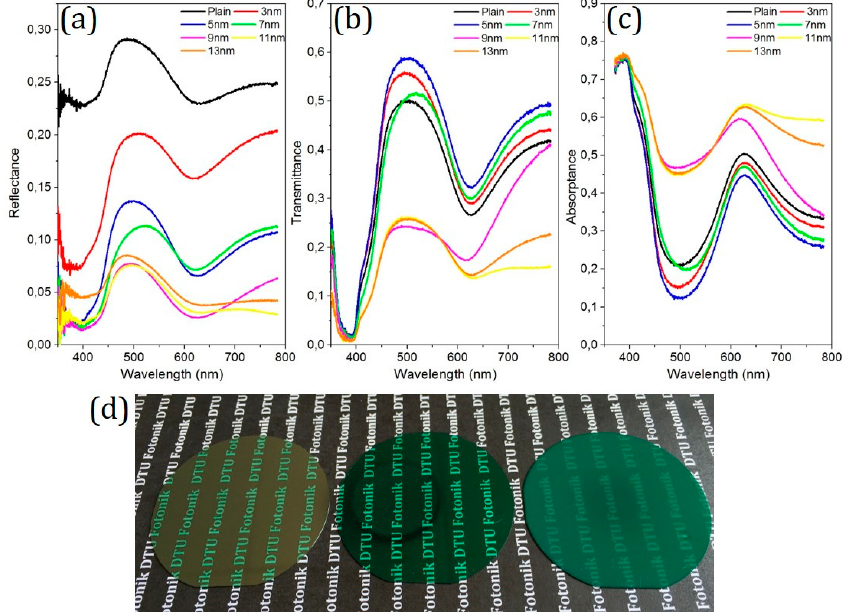
Figure 5. ( a ) Reflectance; ( b ) Transmittance; ( c ) Absorptance of different antireflective structures over the visible spectral range; ( d ) Photo images of 2 inch SiC substrates (from left to right: with plain surface (reference sample), largest transmittance (sample b: 5 nm Au) and lowest reflectance (sample e: 11 nm Au)).